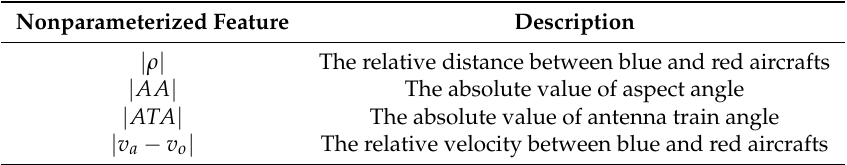
Table 2. The nonparameterized features of aerial